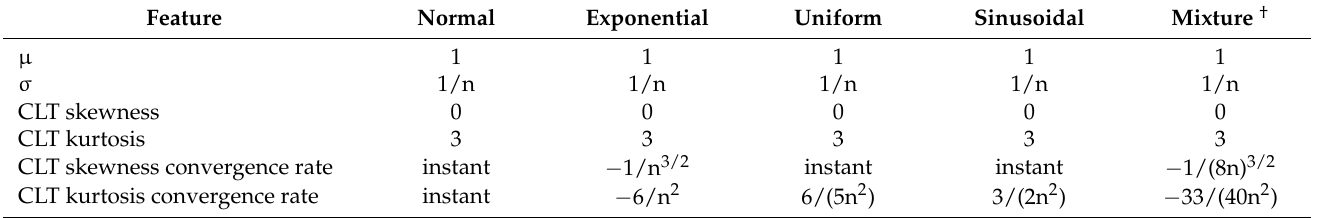
Table 6. CLT outcomes and analytical convergence rates for specimen RVs: Mathematica 12.3 output. Feature Normal Exponential Uniform Sinusoidal Mixture